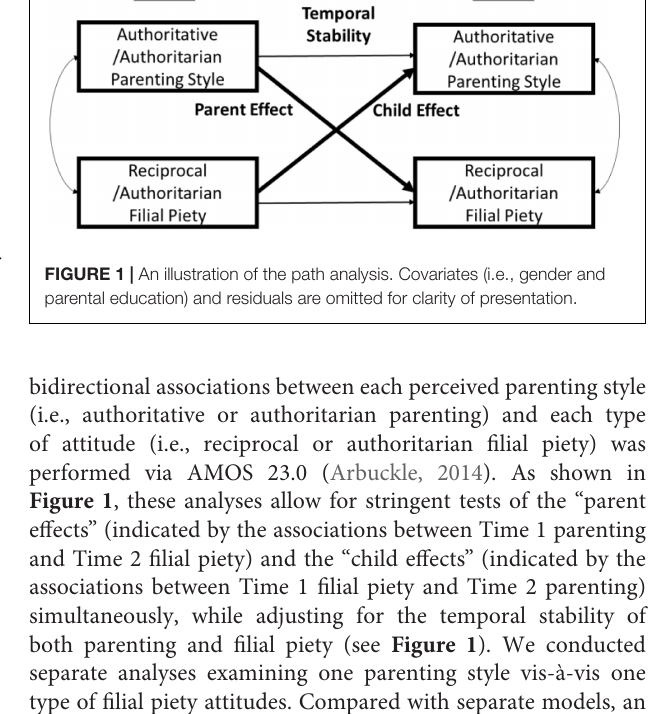
Correlations for the urban sample are above the diagonal, and those for the rural sample are below the diagonal. Gender: 0 = female, 1 = male; parents’ education was indexed by an average score of father’s and mother’s education levels, and their correlations (r) were 0.62*** and 0.26* for urban and rural samples, respectively.